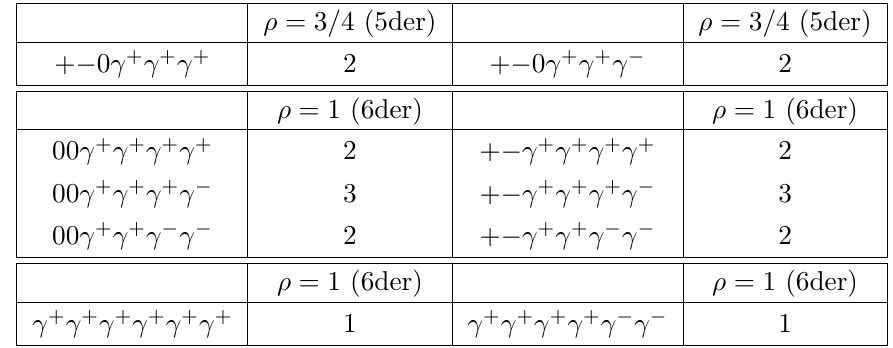
Table 5 . Number of independent monomials for 6pt vertices with three and more photons.